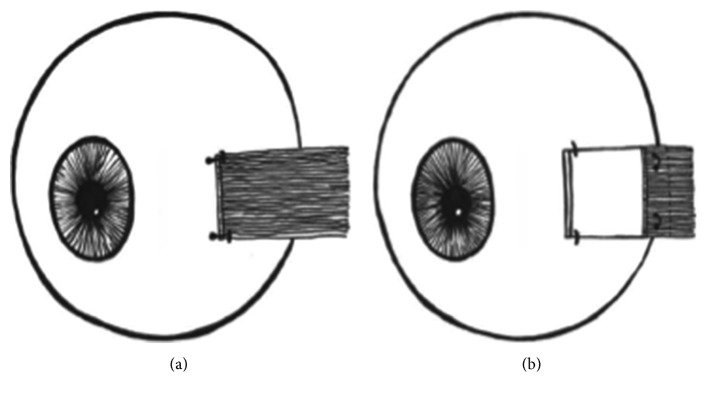
Schematic representation of conventional rectus muscle recession (a) and medial rectus muscle recession with Tutopatch tendon elongation (b). Note that the extraocular muscle comes to lie over Tutopatch, so that there is no direct contact between the tendon stump and the sclera.